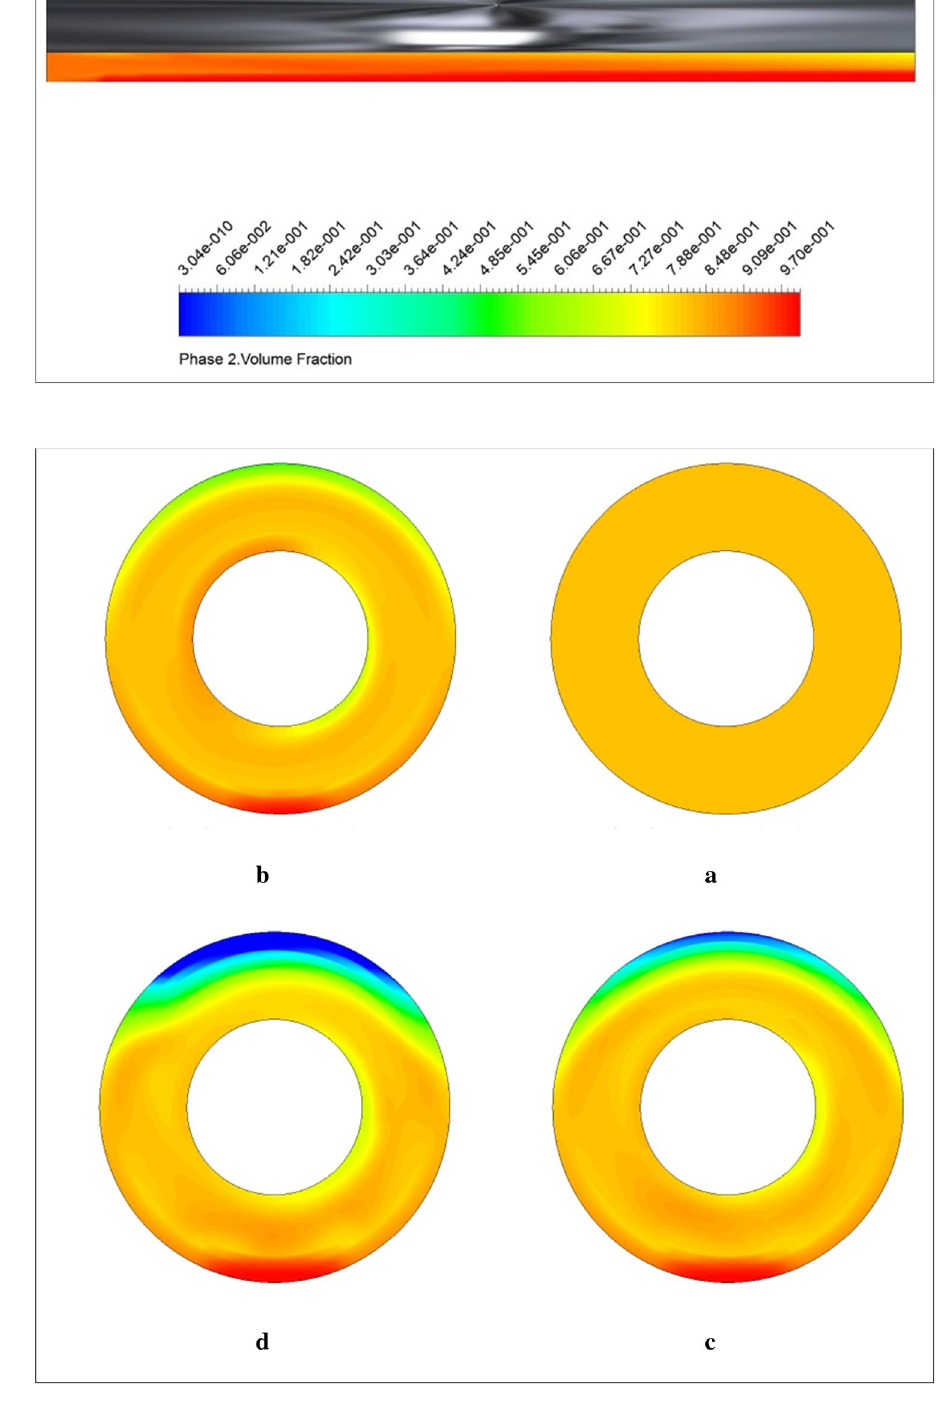
Fig. 13 Volume fraction of the cuttings in a horizontal cross section